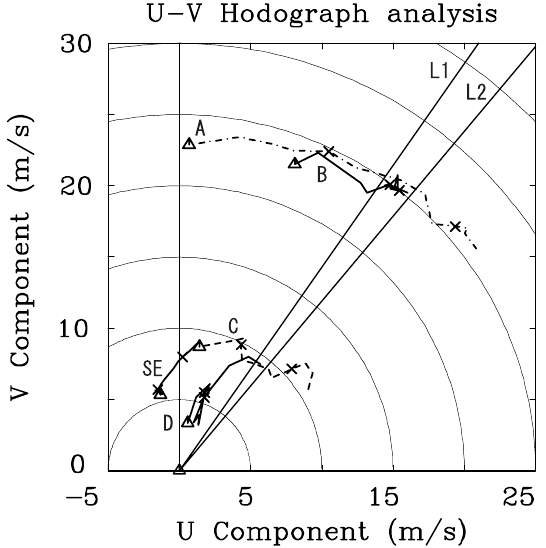
Fig. 10. Hodographs of horizontal wind at NA in periods A, B, C and D (when the Koshikijima line was not observed) and at SE in the period C. The lines L1 and L2 indicate the direction parallel to the rainband in 1999 and 2002, respectively. Triangles ( 4 ) in- dicate surface, and crosses ( × ) are put on the curve at 1km height